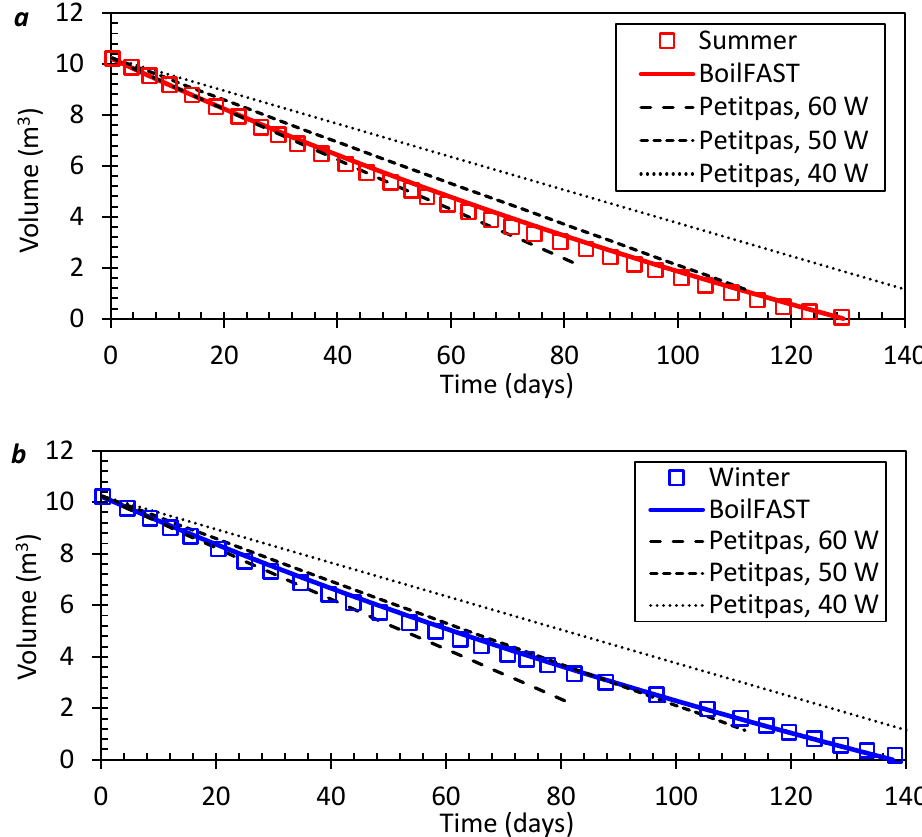
Figure 6. Changes in liquid volume in the 12.5 m 3 Dewar tank during ( a ) summer and ( b ) winter. Symbols correspond to the published experimental data while dotted and solid lines correspond to model calculations from the work of Petitpas and BoilFAST, respectively.